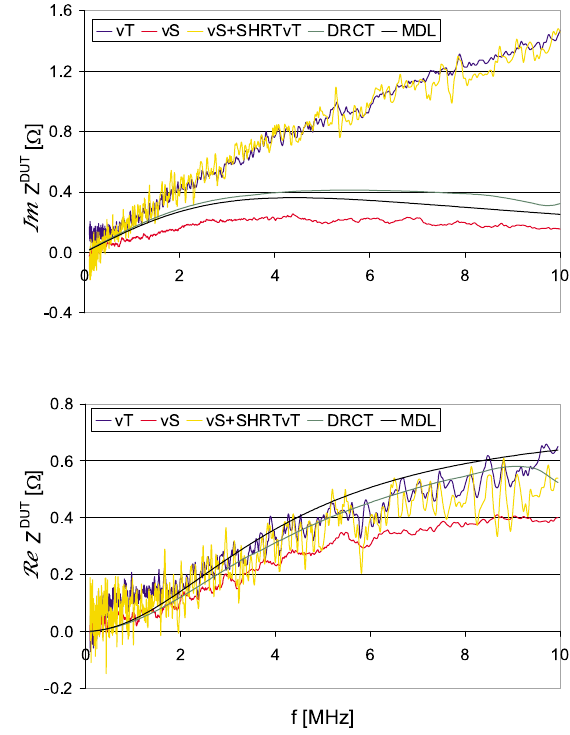
FIG. 12. (Color) Measured DUT impedance of the open kicker